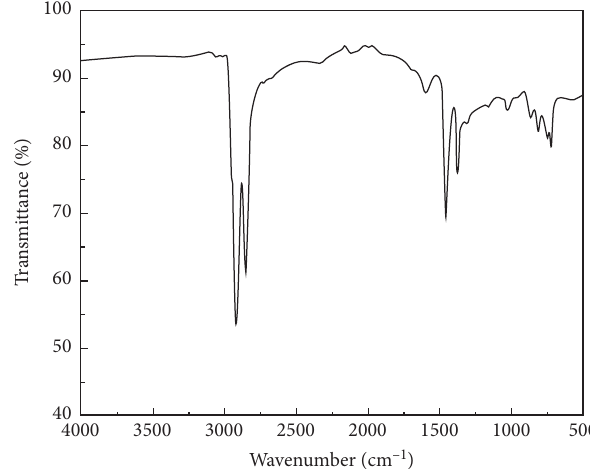
Figure 1: The common mode of infrared fingerprints of the